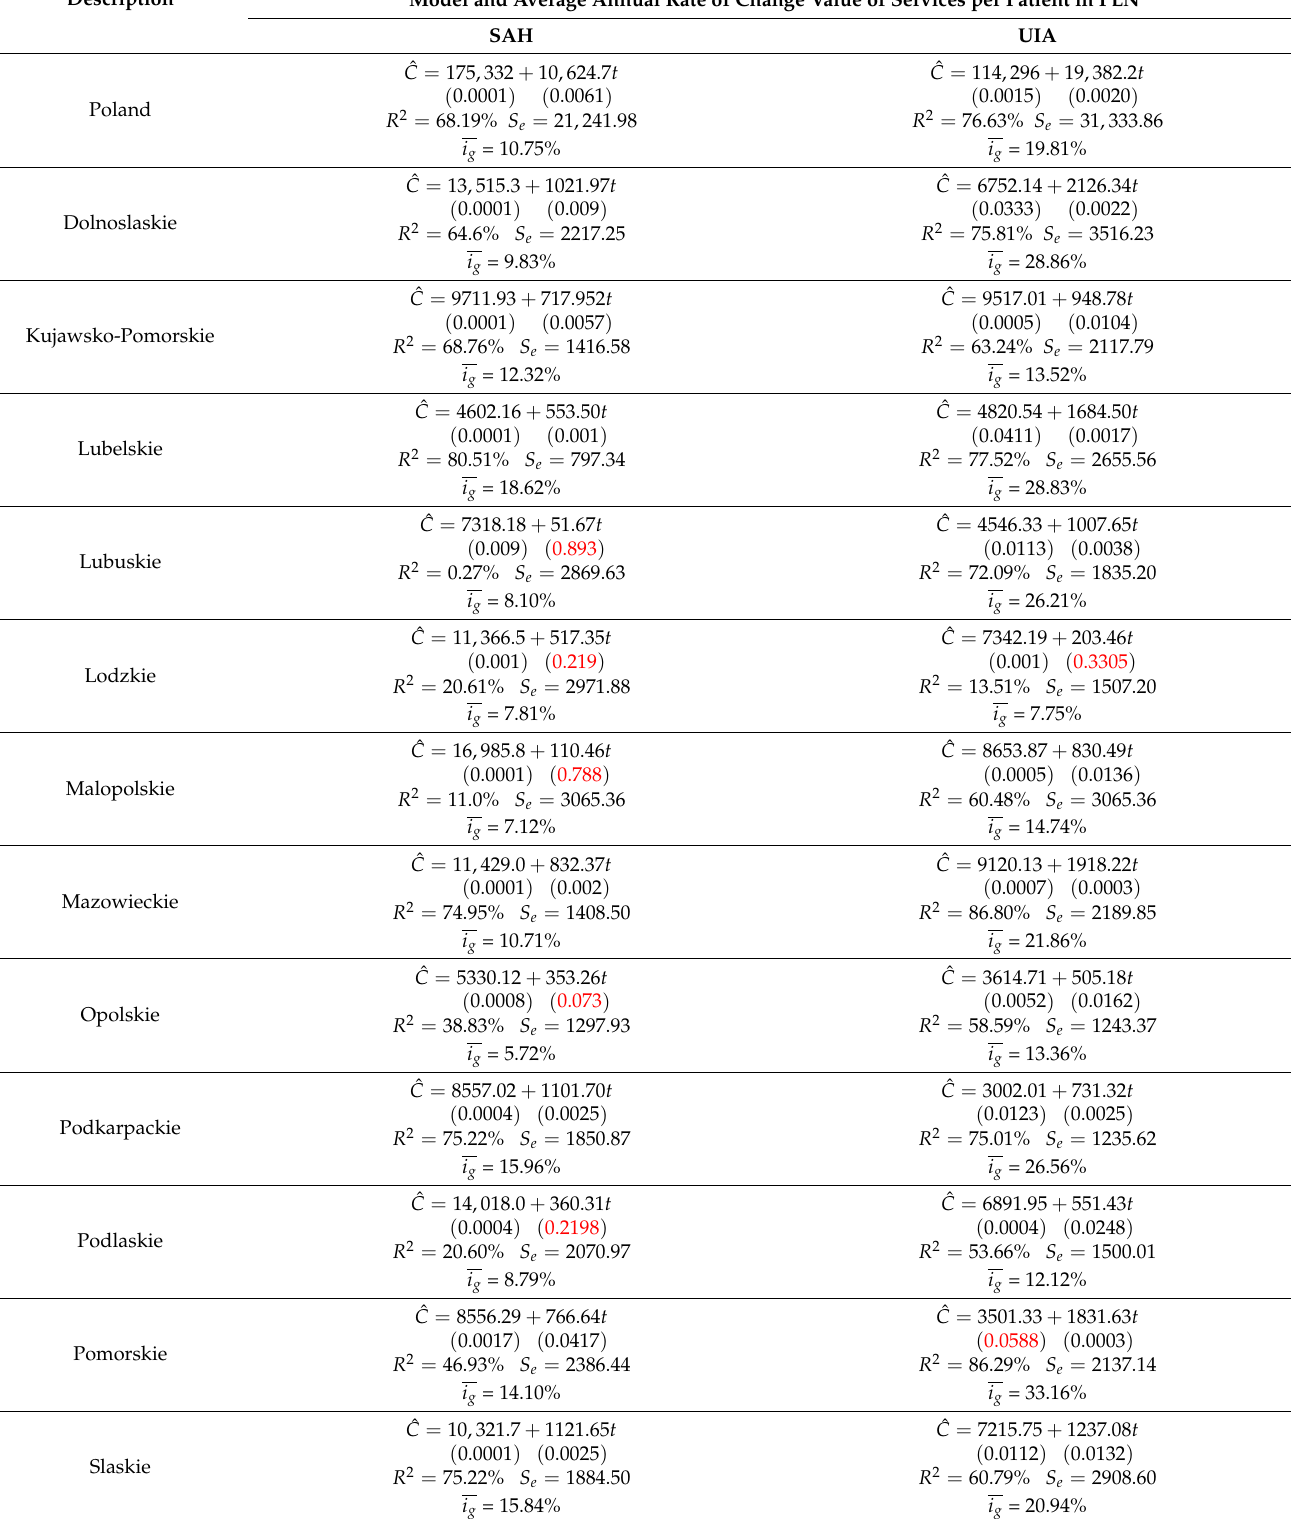
Table 3. The change in levels of reported value of medical services per patient—a summary of linear trend functions and medium-term rates of change from 2013 to 2021 for SAH and UIA diagnoses